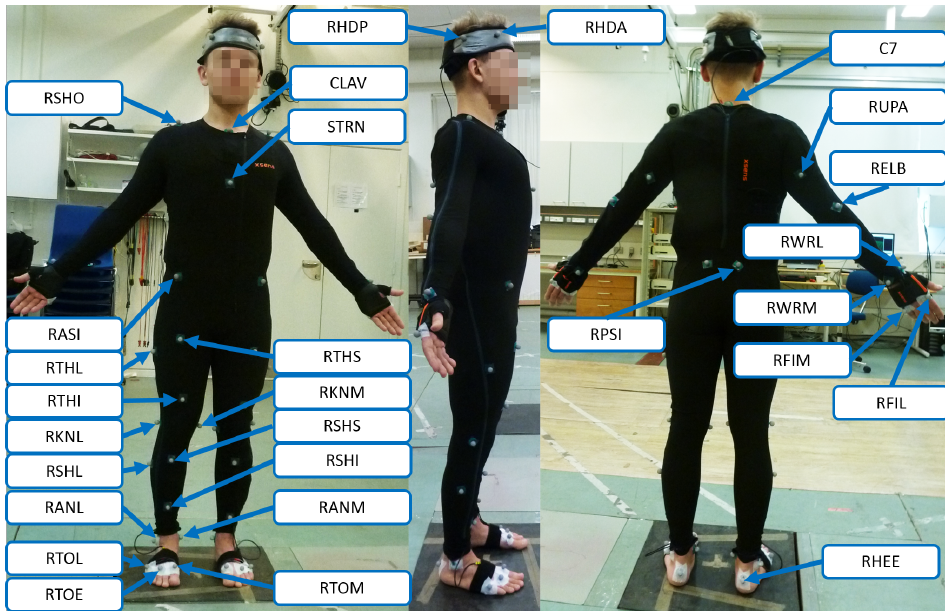
Figure A1. A subject in the wearable instrumentation, indicating the placement of the 53 retroreflective markers on the human body segments. All markers apart from clavicle, sternum and C7 are placed on the left side in a mirrored